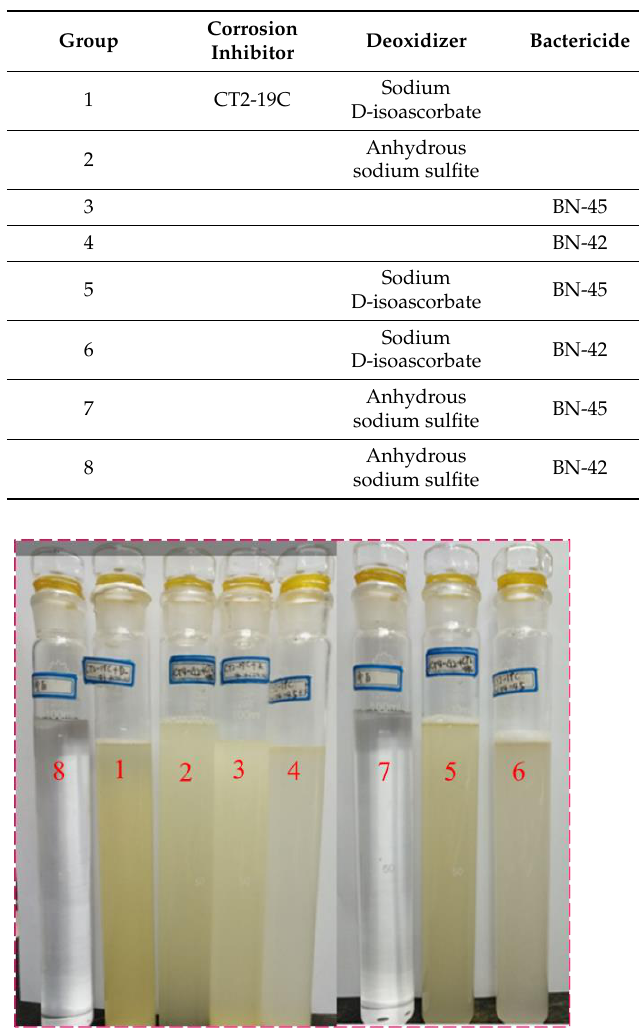
Table 4. Compatibility scheme and results of additives.